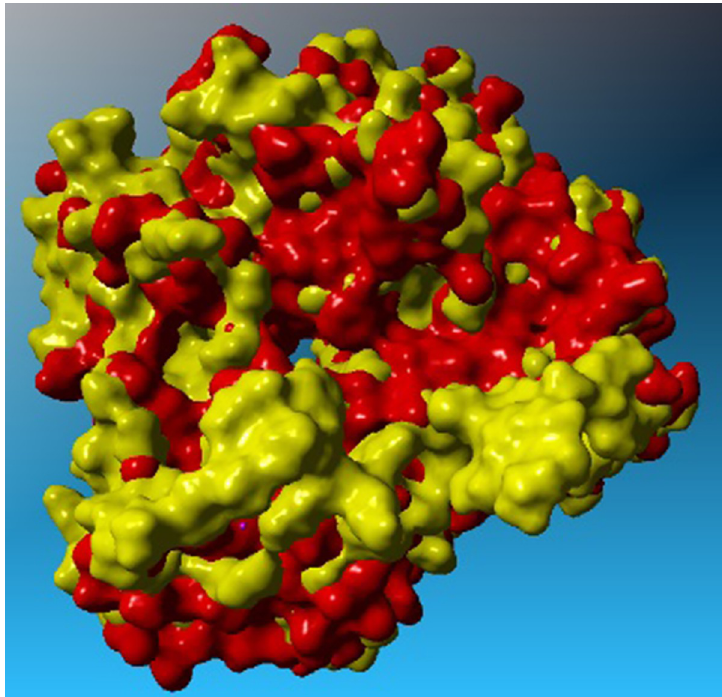
Fig 6. Comparison of the surface of the 3D-structure belongs to the template and MO323 (red and yellow, respectively), differences of structures are relative to turn and coil